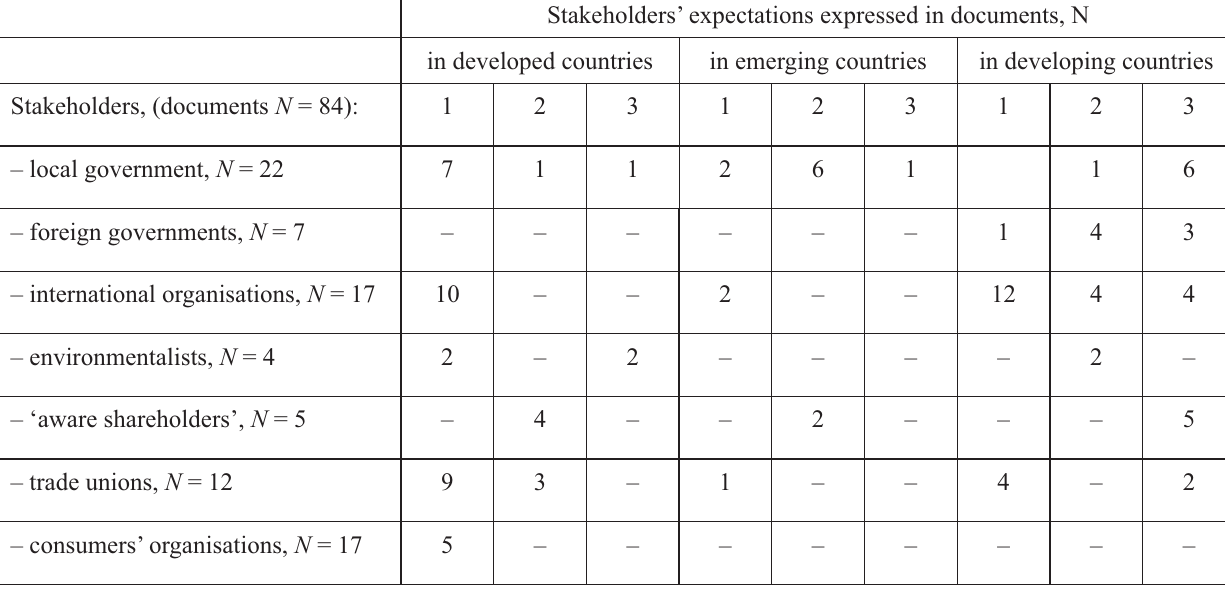
Table 4. Stakeholders’ expectations with regard to business involvement in environmental issues